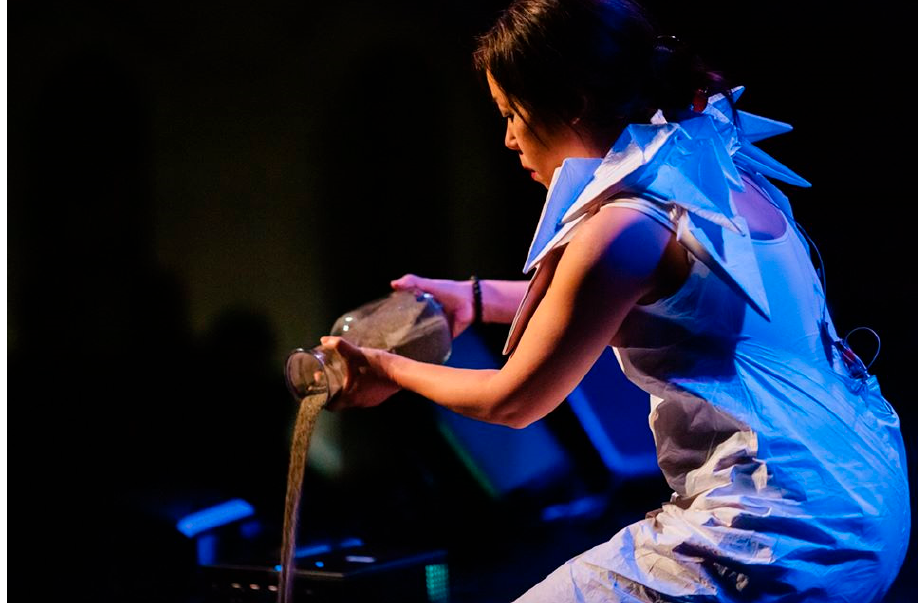
Figure 13. Shin Yu Pai pouring sand from Carkeek Beach near her home, courtesy of Forterra.